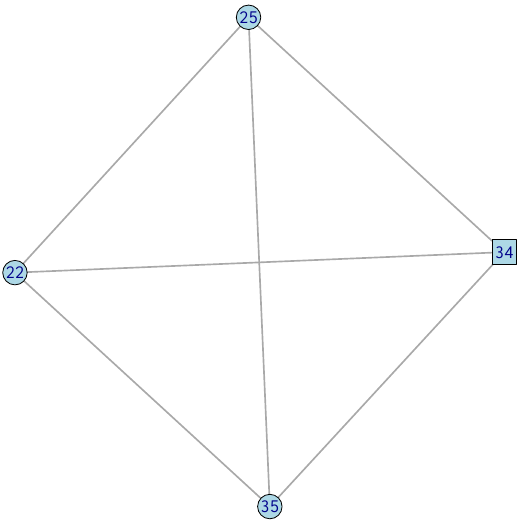
Figure 4. Response to virus ( vir ) GFN. Four genes and six connections in a fully connected graph. TF is represented by squares, while other genes are represented by circles (Supplementary SI.5 for gene